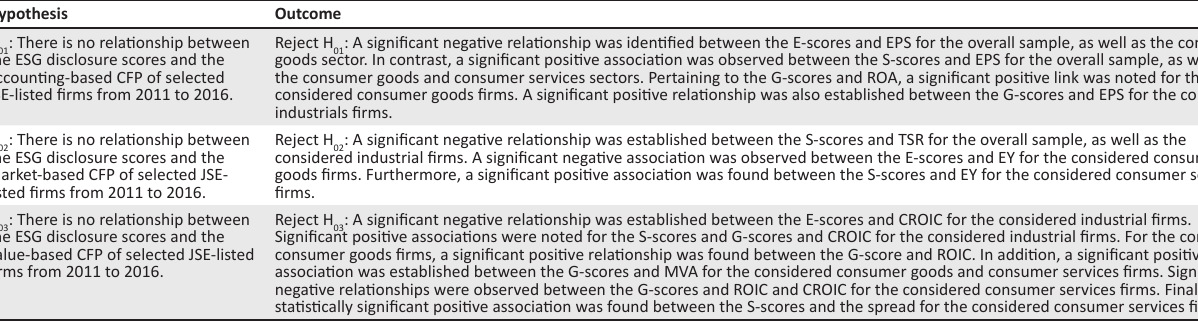
TABLE 7: Summary of the most significant outcomes of the statistical analyses. Hypothesis